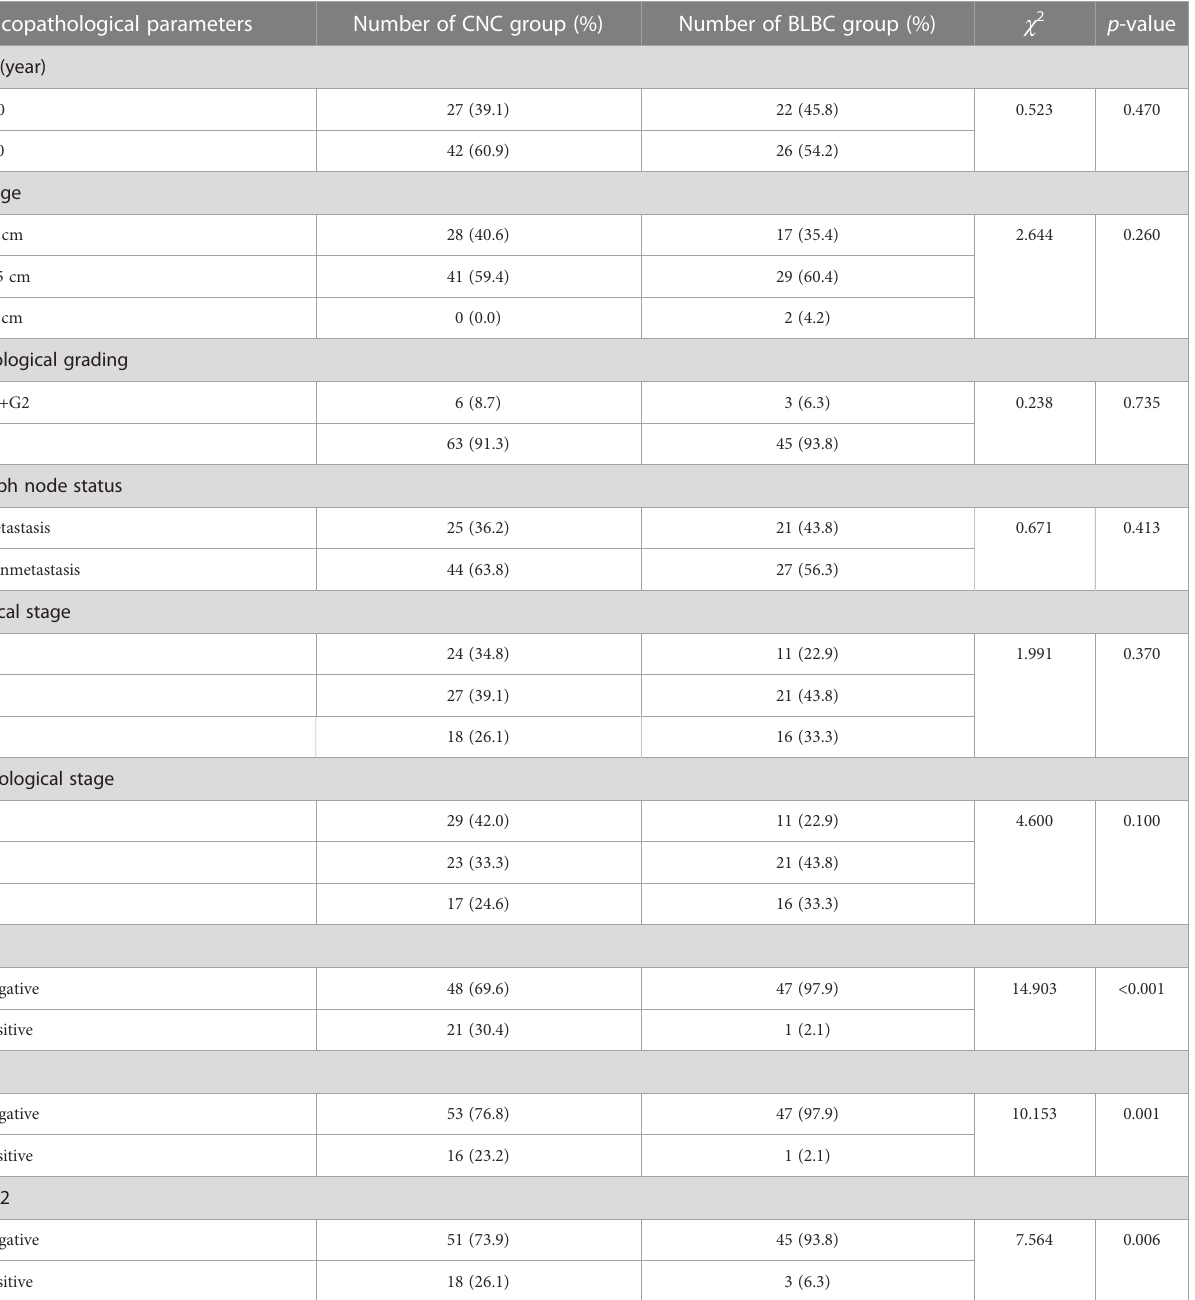
TABLE 1 Comparison of clinicopathological parameters between CNC and